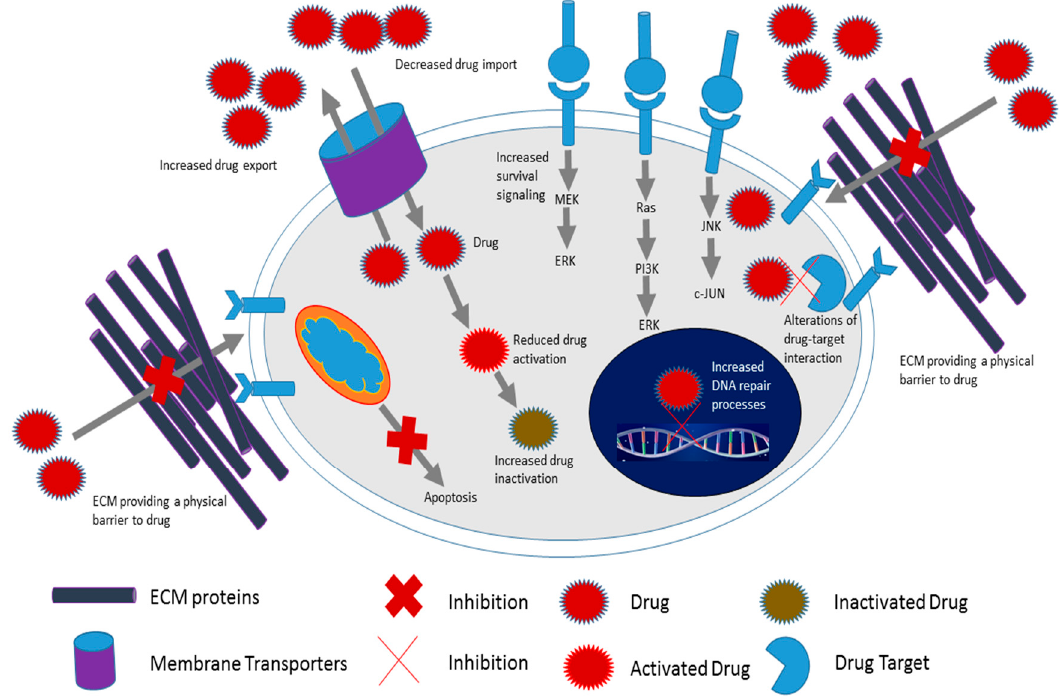
Figure 1. Schematic representation of processes that have been implicated in the development of chemoresistance. Some of these processes include enhanced survival signaling, enhanced drug inactivation, enhanced drug export, reduced drug uptake, inhibition of apoptosis, and increased production of extracellular matrix (ECM) proteins and inhibition of cytoskeleton organization (adapted from [92]).